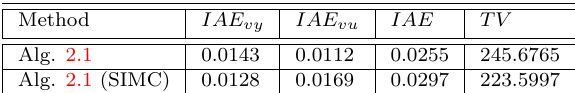
Figure 15: Example 3.8. Simulation of the Segway nonlinear model with PID control. Output and. input step disturbance at, Time = 0.1 Table 12: Example 3.8. Shows the indices IAE vy , IAE vu , IAE (sum) and TV for Alg. 2.1 where δ = 1 . 6, and Alg. 2.1 (SIMC) where